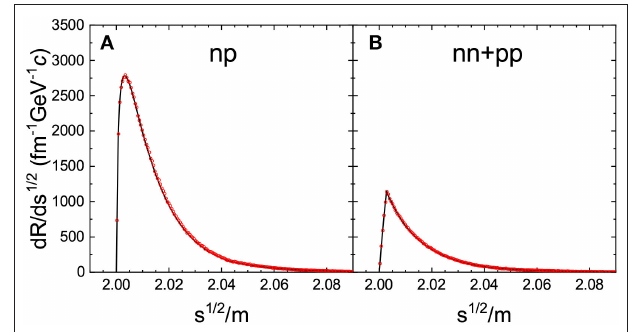
FIGURE 1 | The √ s distribution of (A) np and (B) nn collision rates for the Boltzmann distribution at T 80 neutrons and 80 protons in a cube of volume V 10 10 10 fm 3 , for theoretical predictions (black solid line) = × × and LBUU calculations (red circles). In both calculations, we choose free NN cross-sections as parameterized in reference